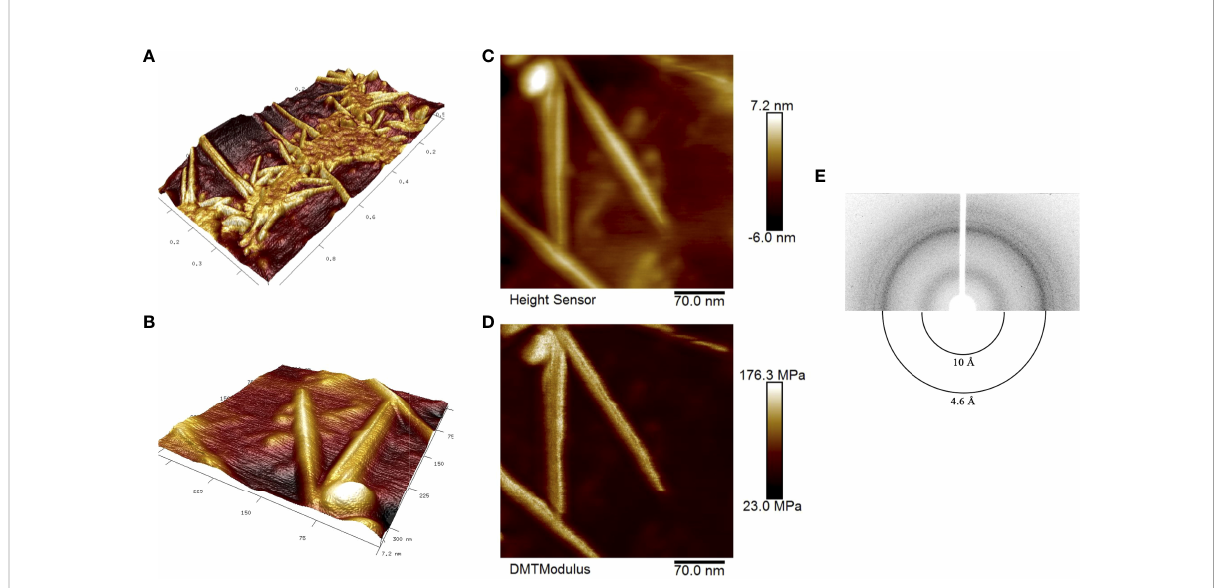
FIGURE 1 Structural properties of the RopB amyloid fi brils obtained in vitro . (A) and (B) high-resolution 3D landscape reconstruction of the RopB fi brils samples by AFM analysis at different magni fi cations: general view in microns (A) and individual fi brils, nm (B) . (C) Height Sensor image shows the RopB fi brils height. Scale bar are shown, nm. (D) DMT modulus image shows rigidity of the fi brils. Scale bar are shown, MPa. (E) X-ray diffraction patterns of the lyophilized RopB fi brils formed in vitro . Shown are re fl ections in angstroms